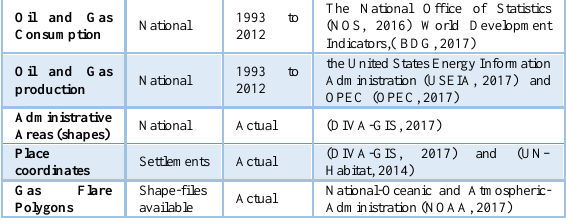
Table 1. Socio-economic Parameters and Data Sets used in this